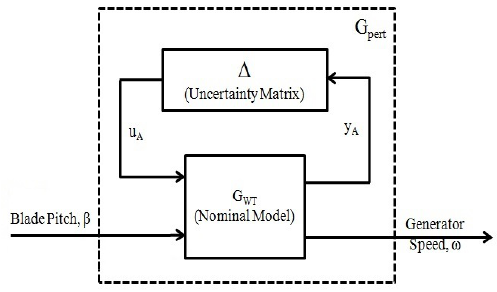
Figure 3. Block diagram representation of an uncertain wind turbine [20].